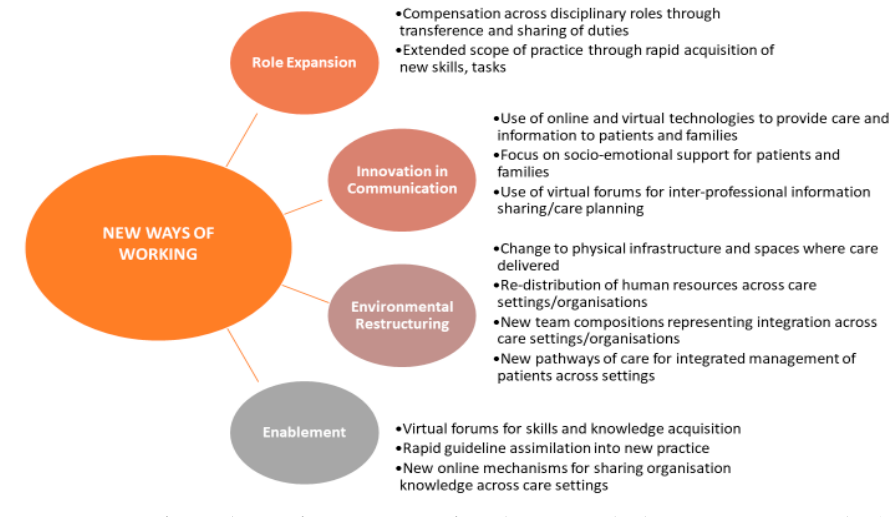
Figure 3. Summary of Key Themes for New Ways of Working Described in Newspaper Articles ( N = 34).